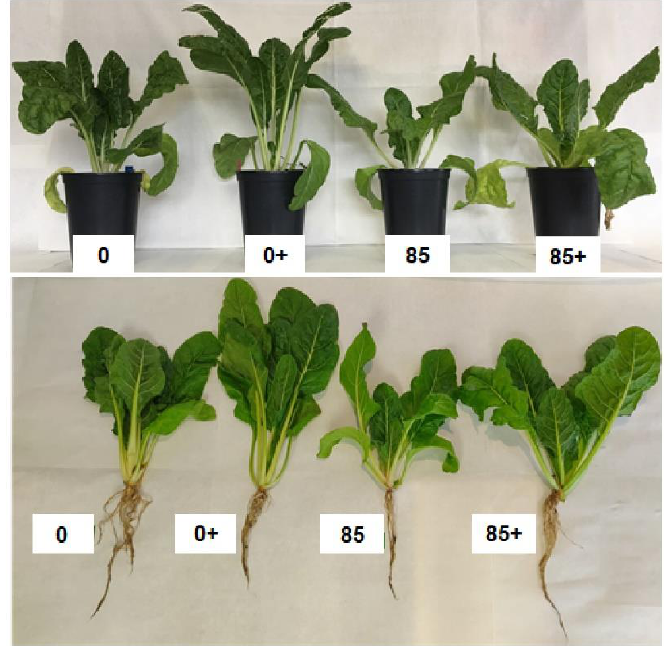
Figure 2. Swiss chard plants grown with 0 and 85 mmol L −1 NaCl, non-inoculated and inoculated (+). In the upper image, the plants are shown in their pots, and in the lower image, the same plants can be observed after they are removed from the pots and washing their roots.